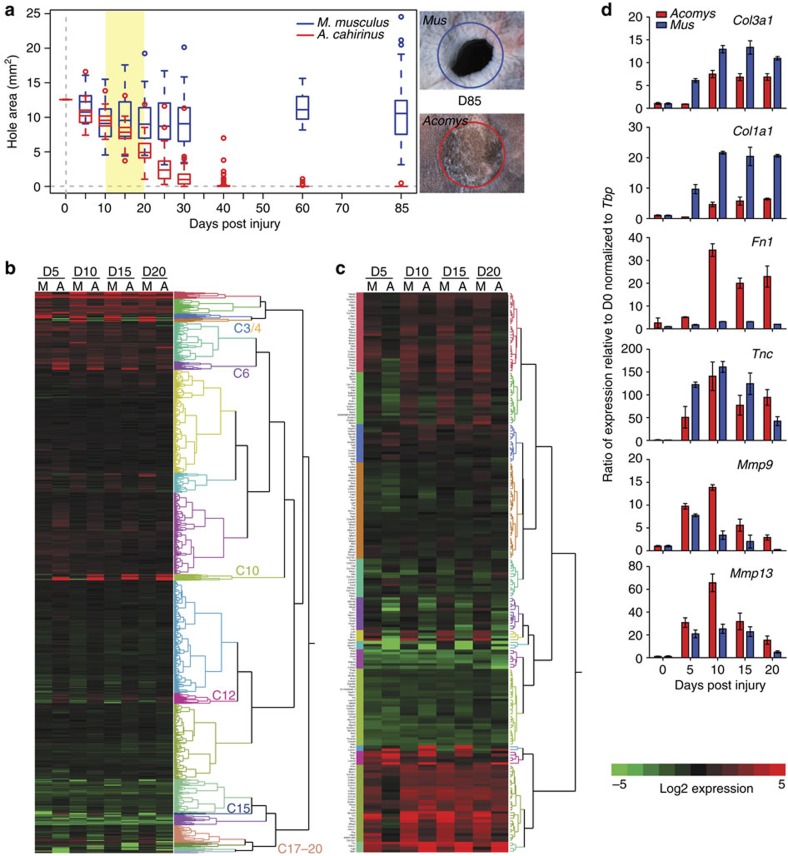
Analysis of global transcription reveals a regeneration-specific transcriptional response associated with ECM-related genes.(a) Ear-hole area following 4-mm ear-hole punch assay in M. musculus (blue) and A. cahirinus (red). Data represent box and whisker plots from male and female individuals re-plotted from Fig. 1a. Adjacent images of representative ears at D85 for M. musculus (top) and A. cahirinus (bottom). Blue and red circles indicate initial wound. Regenerated hair follicles are present in A. cahirinus. (b) Heatmap showing expression relative to D0 for global transcription from M. musculus (M) and A. cahirinus (A) at D5, D10, D15 and D20. Tree to the right of heatmap represents the ontogeny of gene expression and each colour is used to separate the genes into 20 unique clusters via hierarchical clustering based on expression pattern (C3/C4=up in M, no change in A; C6/C10=no change in M, up in A; C12=down in M, up in A; C15=down in M, up in A; C17/C18/C19/C20=no change in M, down in A). (c) Heatmap for 204 out of 277 genes from the core murine matrisome (glycoproteins, collagens and proteoglycans). Data represent log2(mean expression) calculated from EBseq averaged over n=3 biological replicates at each time point per species (b,c). (d) Quantitative PCR results for select genes from matrisome. Data represent mean and s.e.m. for n=3 biological replicates at each time point per species.